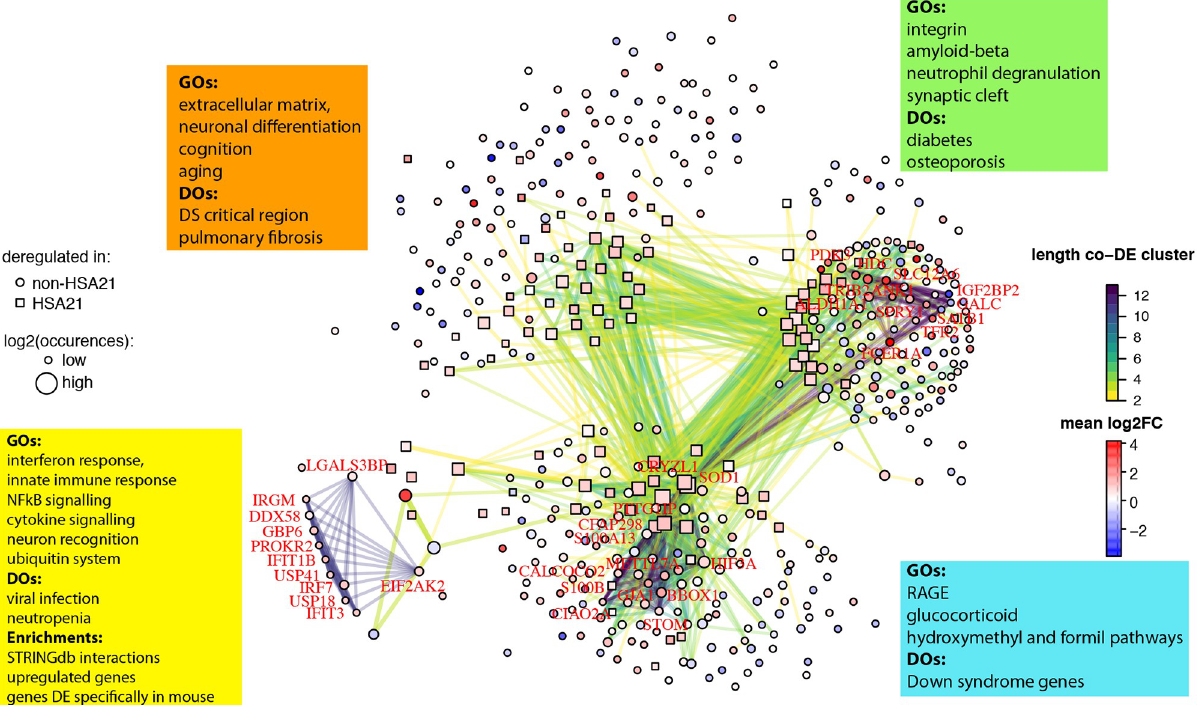
Fig 5. DS genes form a modular network. DS network where each node is a gene found DE in at least 4 comparisons. Edges represent co-DE events between genes colored based on the size of the co-DE cluster. Edge thickness is proportional to the number of occurrences of co-DE and the STRINGdb score. We did not plot the edges corresponding to co-DE pairs found in less than 4 comparisons). Size is proportional to the log 2 of the occurrences of DE. Genes encoded by HSA21 are depicted with a square, non-HSA21 with a circle. The significant enrichments for each module are indicated with boxes of different